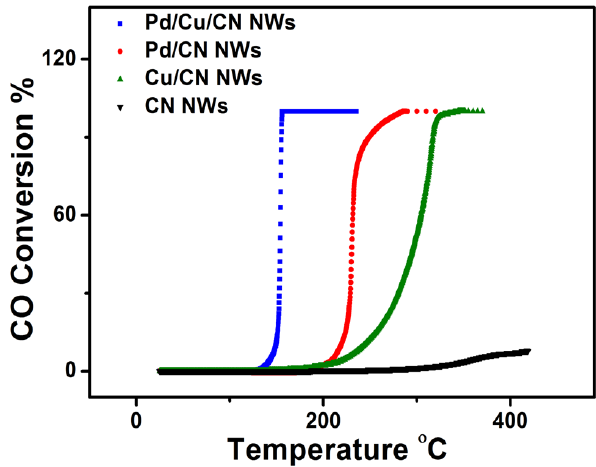
Figure 6. CO conversion efficiency on the as-synthesized Pd/Cu/CN NWs, Pd/CN NWs, Cu/CN NWs, and CN NWs as a function of temperature.